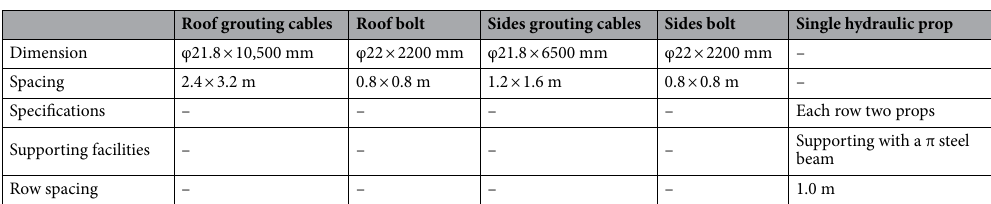
Table 1. Previous supporting